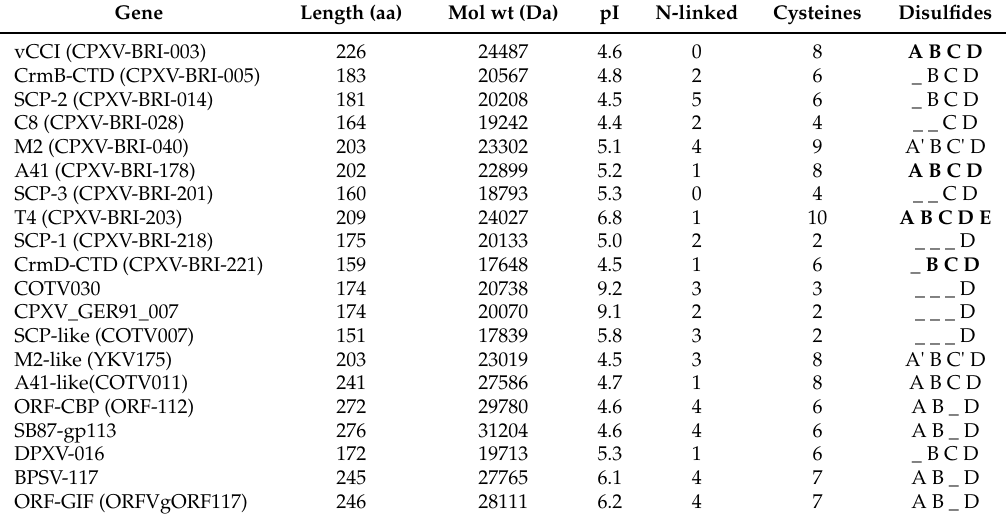
Table 3. Predicted Physical Properties of PIE and Putative PIE Domains. The amino acid length, molecular weight, isoelectric point, and number of cysteines for each protein were calculated using ProtParam [79]. The number of predicted N-linked carbohydrates was calculated using NetNGlyc1.0 [80]. The disulfide positions were taken from the alignment in Figure 6 and lettered as in Figure 2. The disulfides shown in bold typeface were determined from the structures in Figure